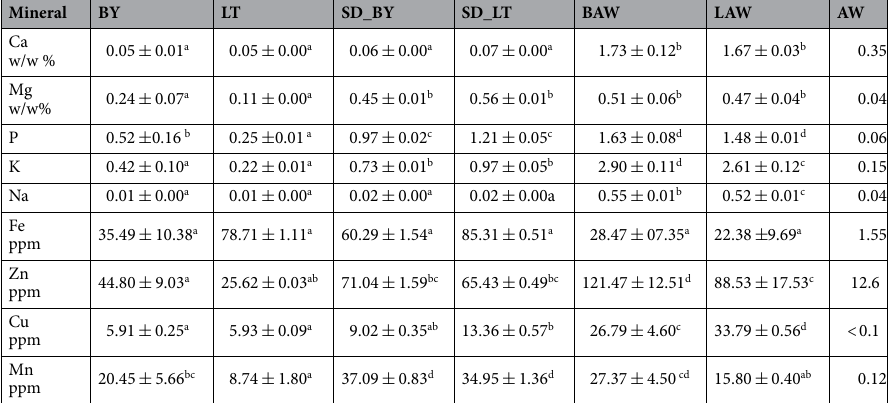
Table 4. Mineral content comparison of millet flour, AWM powder samples, and liquid acid whey. Means having different letters as superscripts within the same row differs significantly at p < 0.05. < = values are below detection limit. AW was not included in the significance test. The AW data for P, K, Na was obtained from Wong et al. 6 Mineral content in the powder and liquid acid whey samples. BY: plain Barnyard millet flour; LT: plain Little millet flour; SD_BY: spray dried Barnyard millet soluble fraction; SD_LT: spray dried Little millet soluble fraction; BAW: 25% w/v Barnyard millet + acid whey; LAW: 25% w/v Little millet + acid whey; AW: liquid acid